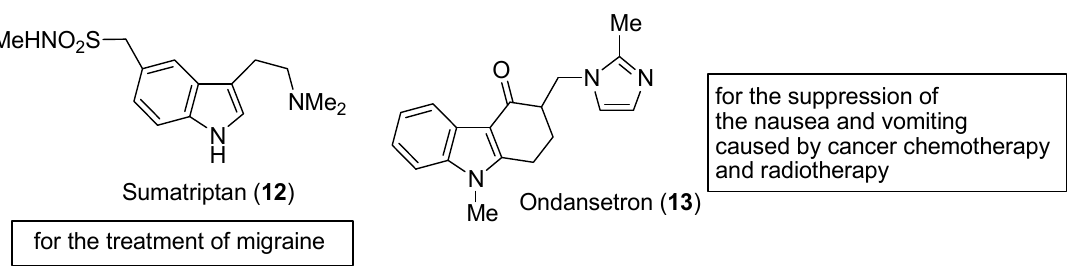
Figure 4. Structure of indoles used in